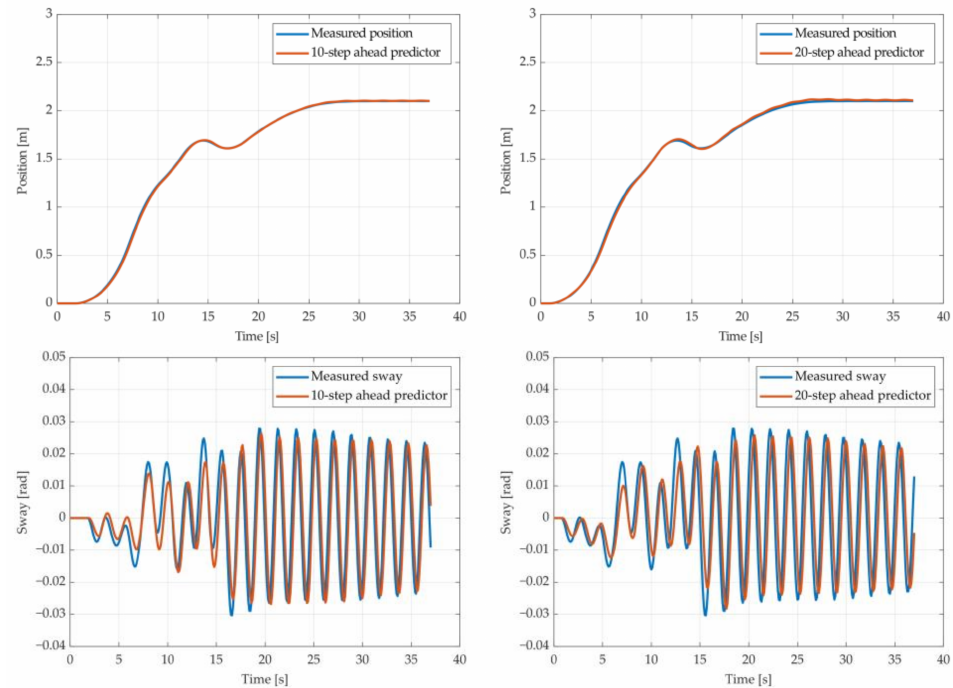
Figure 9. The 10- and 20-step ahead prediction with the ARX model of the simulated crane position and payload sway with 0.9 m rope length and 10 kg payload mass.